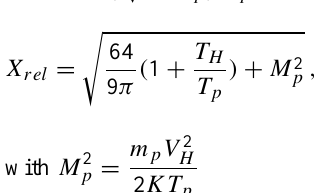
Fig. 1. Shown as a function of the plasma wall coordinate x = z/D , D = 50AU being the linear extent of the plasma wall, is the H- atom bulk velocity V H in units of [km/s] (left ordinate) and the h i H-atom pressure P H in units of 10 − 13 dyne/cm 2 (right ordinate) calculated for various values of the parameter 3 = Dσ rel n p . The H-atom flow in all cases enters the plasma wall at x = 0 with a velocity of V H ( 0 ) = 25 km/s. Curves reaching the singular point x c where γP H,c = C 0 V H,c stop at this